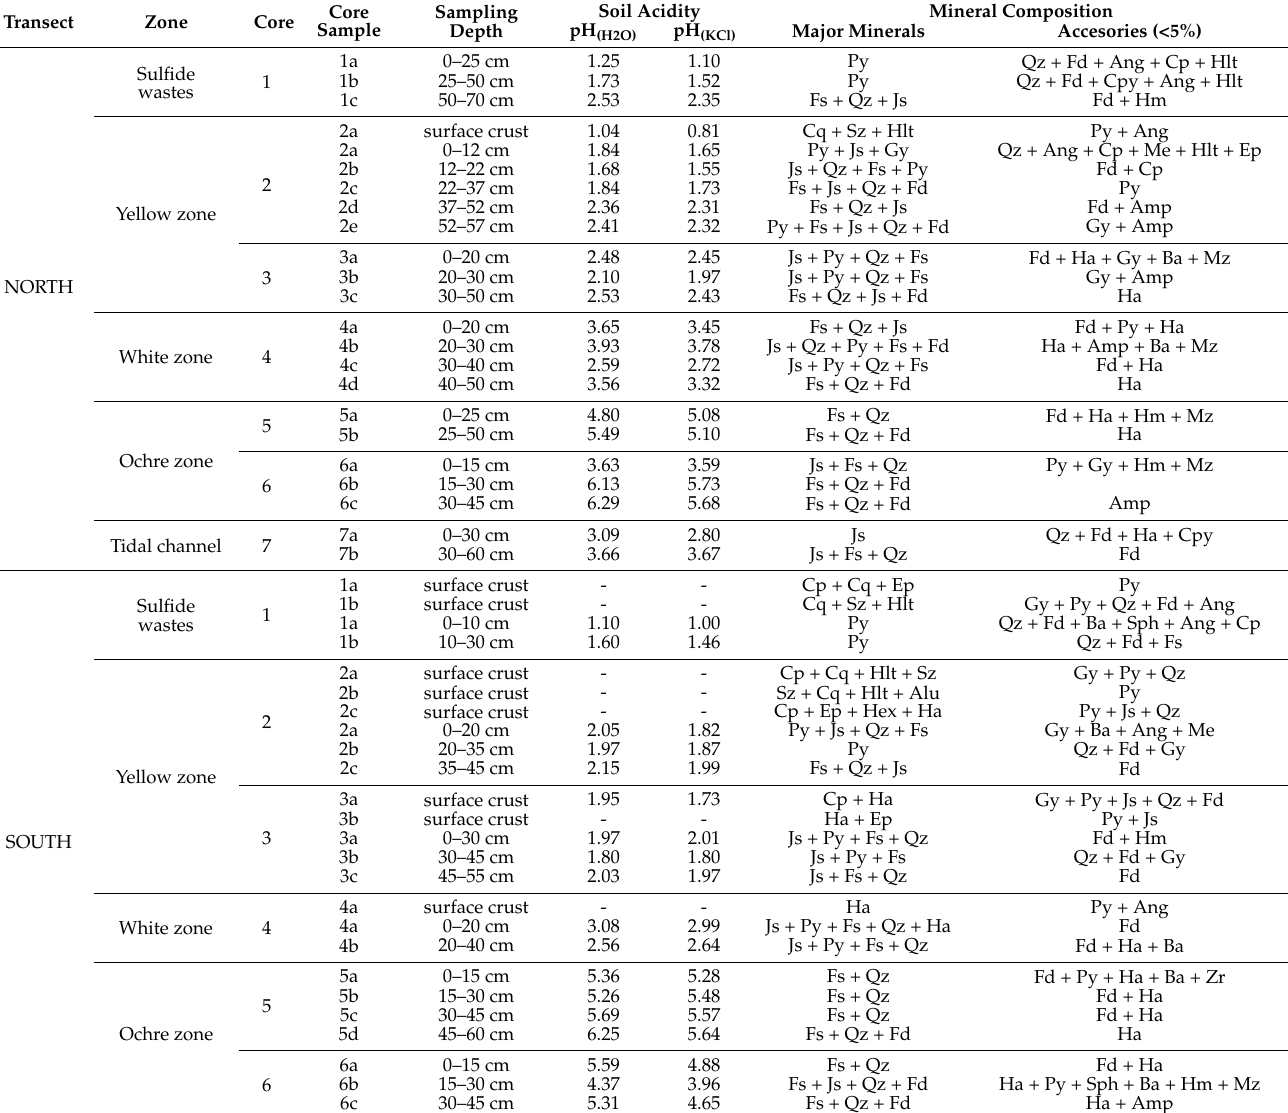
Table 1. Soil pH values in water (actual acidity) and in KCl (potential acidity), and mineral composition of the soil core samples and efflorescent crusts. Mineral abbreviations as defined in Supplementary Table